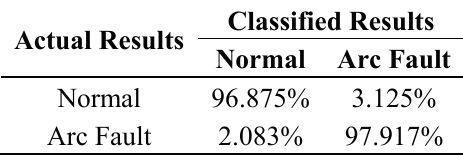
Table 2. Confusion matrix for LSSVM